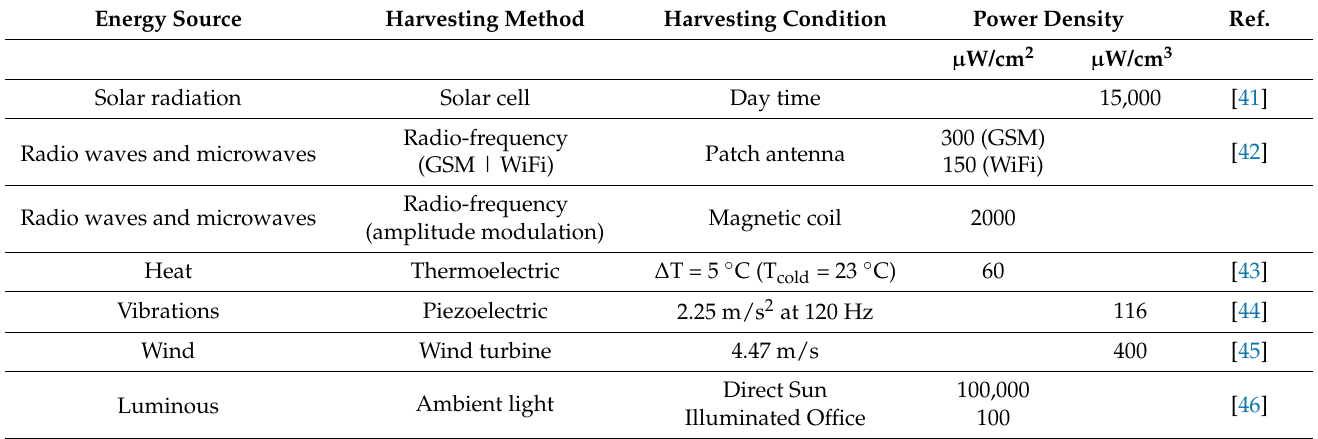
Table 1. Available energy sources for wearable harvesting applications